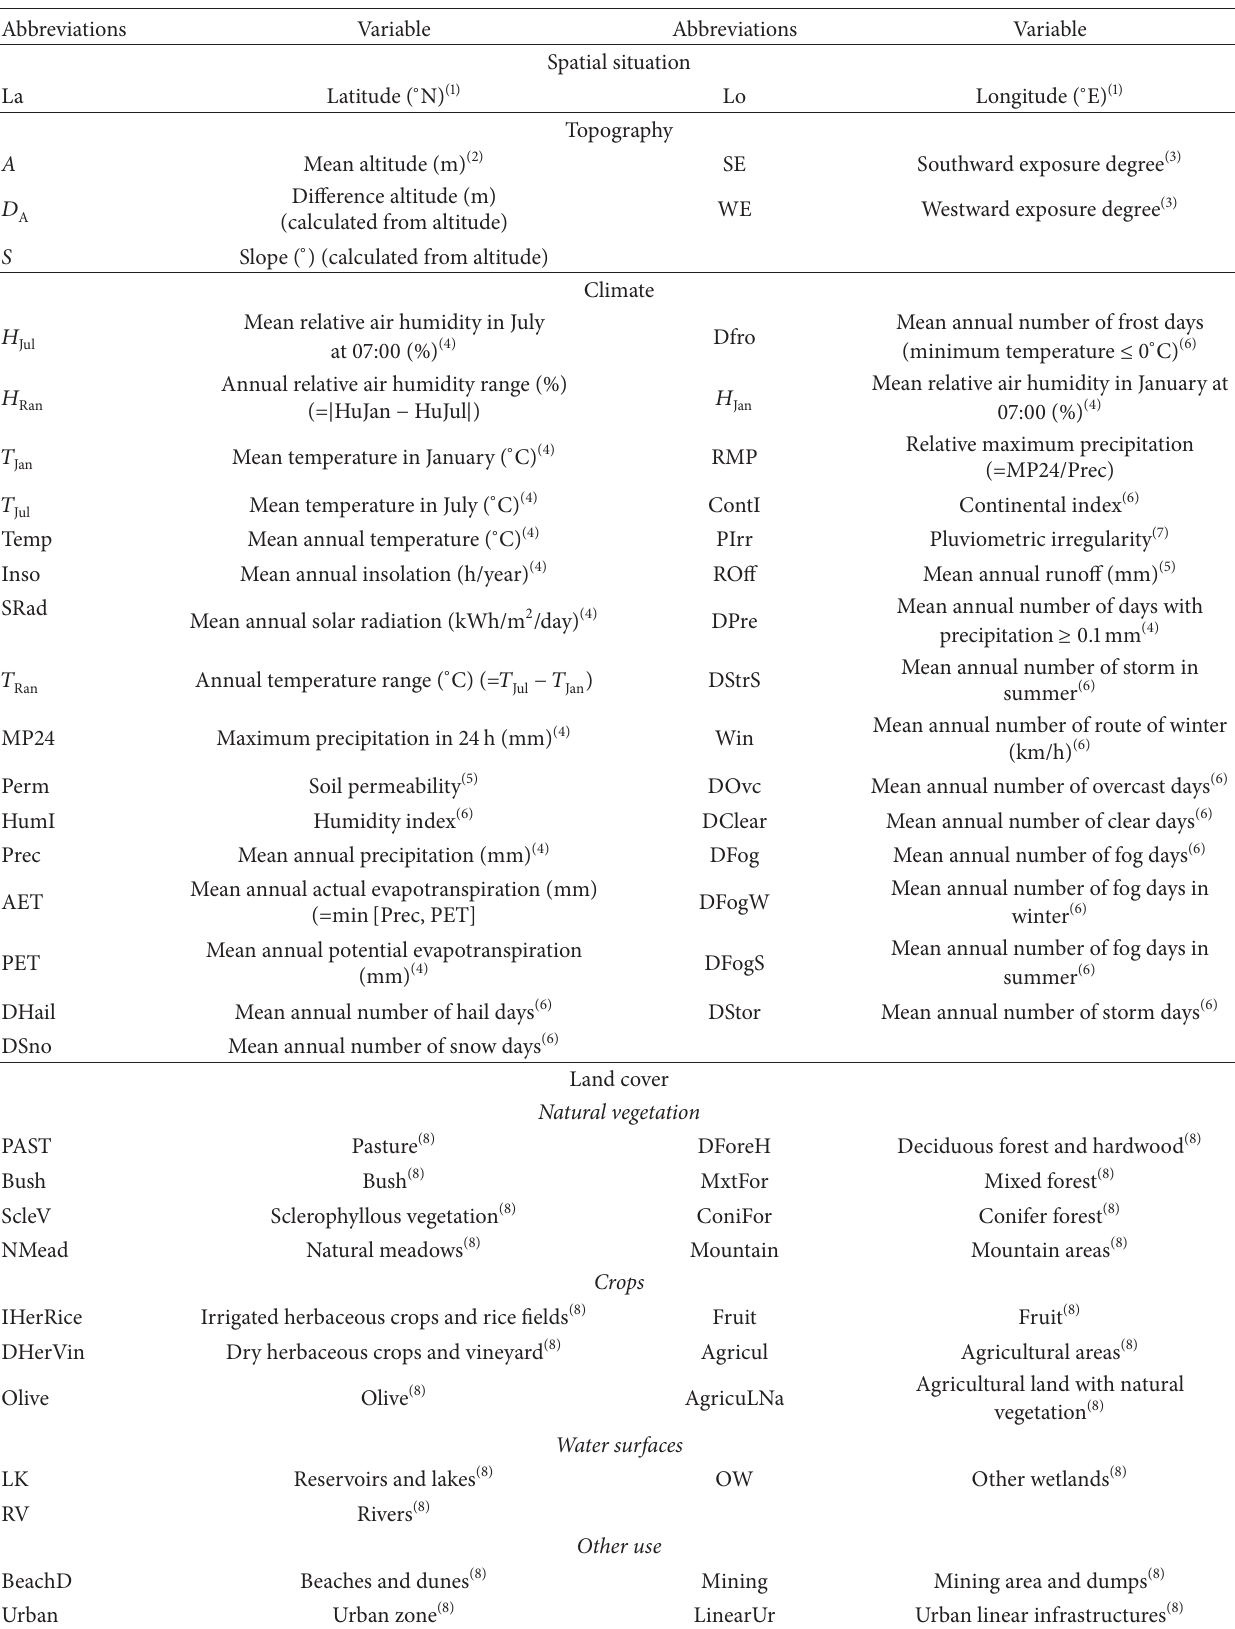
Table 1: Variables used to model the distribution of Trachemys scripta and Mauremys leprosa